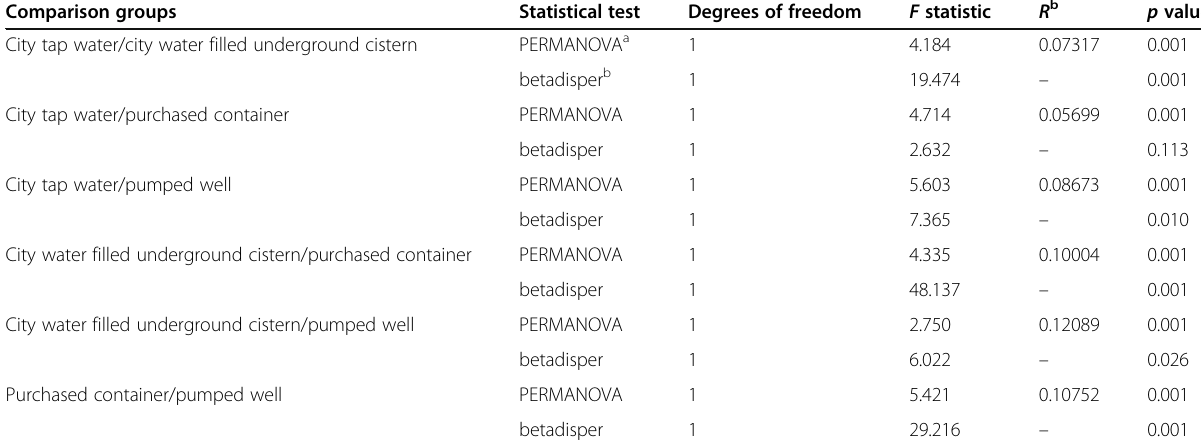
Table 6 Statistical tests of bacterial communities by water source type Comparison